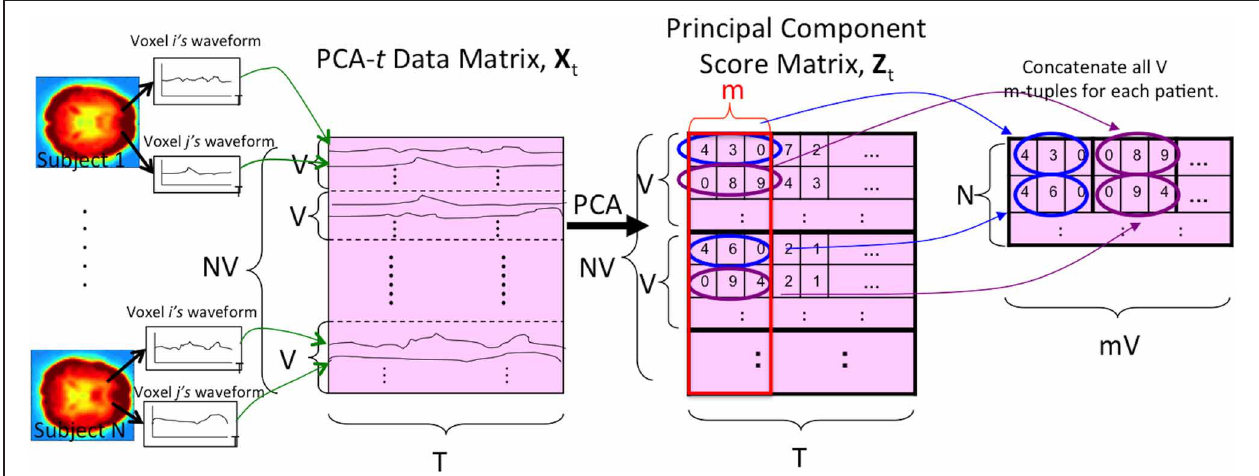
FIGURE 4 | The PCA- t process. V is the number of voxels per subject. N is the number of subjects. T is the length of each voxel’s waveform in number of time points. All V voxel waveforms from all N subjects were represented by the rows of the data matrix X t . After running PCA on this matrix, the m largest principal component scores of each subject’s